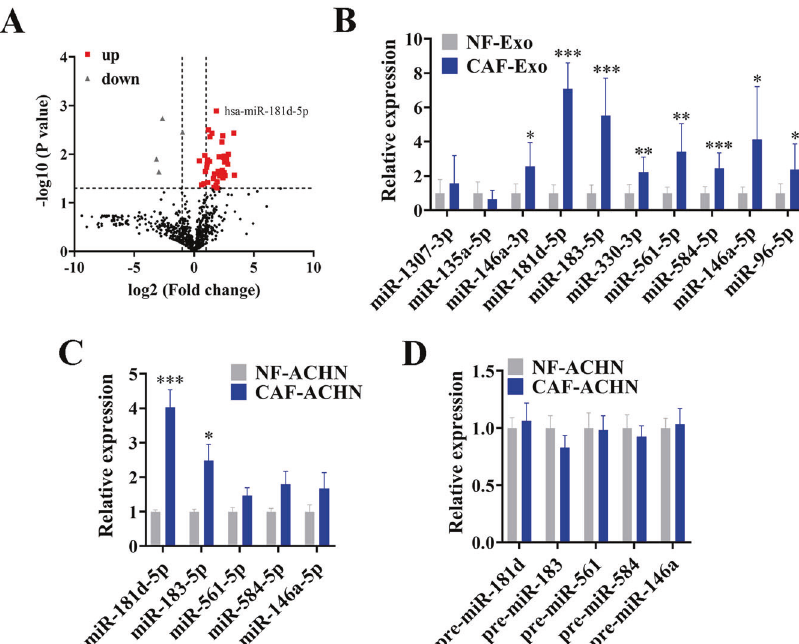
Fig. 4 CAFs deliver exosomal miR-181d-5p to RCC cells. A Volcano Plot of differentially expressed miRNAs pro fi le between CAF-Exo and NF- Exo by small RNA sequence, n = 3; B RT-qPCR analysis of exosomal miRNAs in NF-Exo and CAF-Exo, n = 8, normalized to U6; C RT-qPCR analysis of miRNAs expression in ACHN cells after treated with NF-Exo or CAF-Exo, normalized to U6; D RT-qPCR analysis of pre-miRNAs expression in ACHN cells after treated with NF-Exo or CAF-Exo, normalized to U6. Cell experiment was repeated three times independently, P value between the two groups was obtained by Unpaired t test. * P < 0.05; ** P < 0.01; *** P <